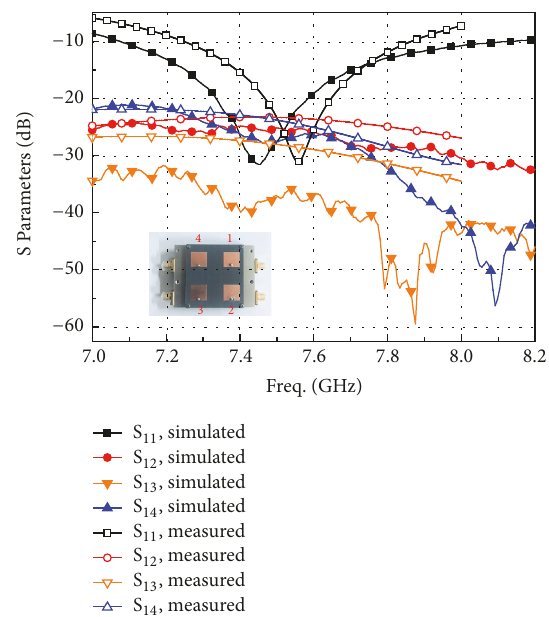
Figure 11: Simulated and measured return loss for the OAM generator (a=18.3mm).